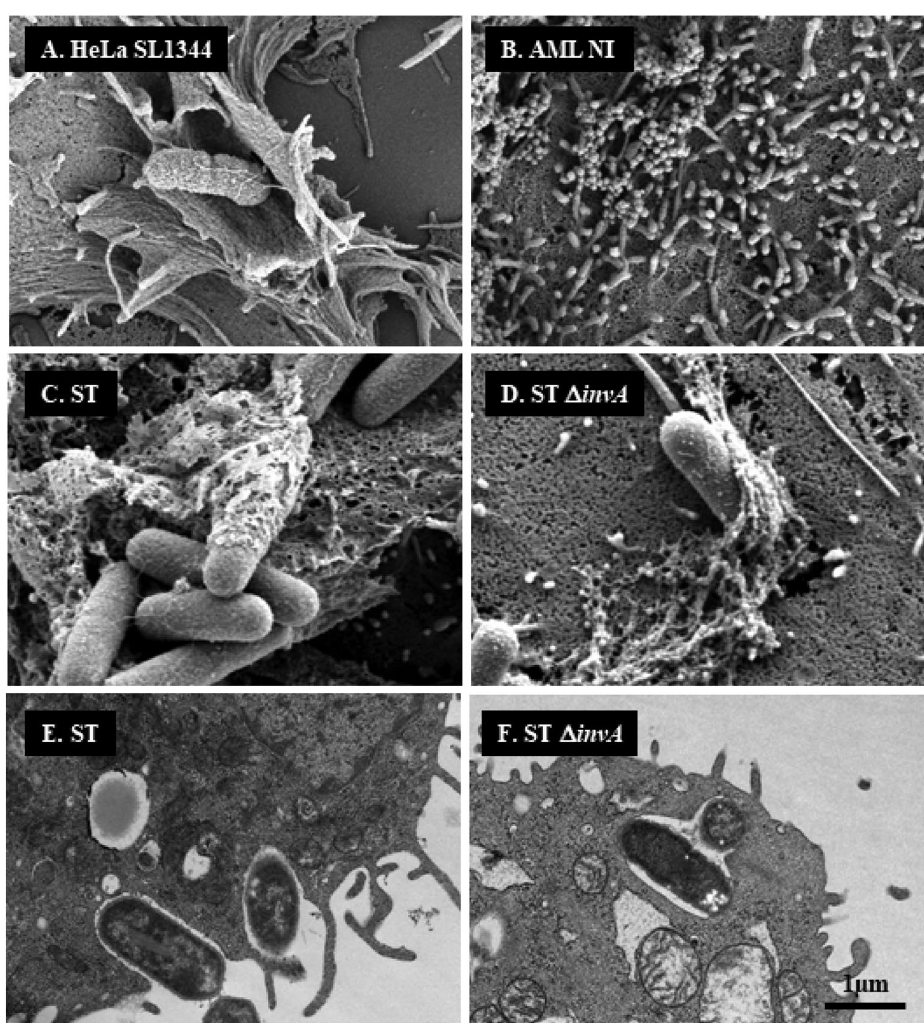
Figure 2. Weak cell membrane rearrangements observed by electron microscopy during invasion illustrate a zipper mechanism for both ST and ST Δ invA strains in AML12 cells. ( A ) HeLa cells infected for 30 min with Salmonella Typhimurium (SL1344) as a trigger reference model. ( B ) AML12 cells not infected, or ( C , E ) infected with ST or ( D , F ) infected with ST Δ invA for 60 min. ( A – D ) Infected HeLa cells and non-infected or infected AML12 cells cultured on glass coverslips were used to evaluate membrane ruffling using scanning electron microscopy. ( E , F ) Infected AML12 cells were trypsinized and used for transmission electron microscopy observation of ultra-thin sections of embedded cells in resin after fixation and impregnation. Scale bars 1